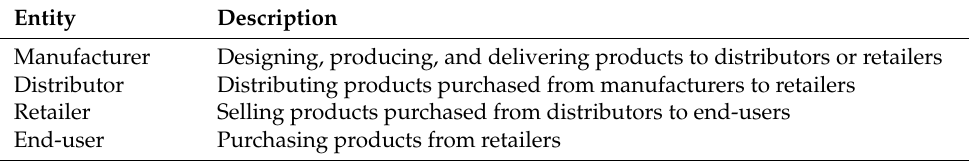
Table 3. Supply chain nodes and their